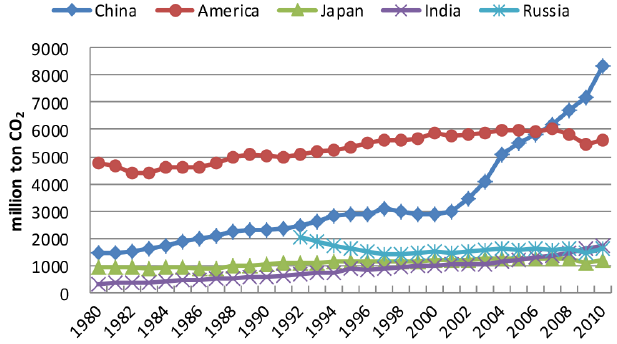
Figure 1. Top five of total CO 2 emission in the world (U.S. Energy Information Administration, EIA,